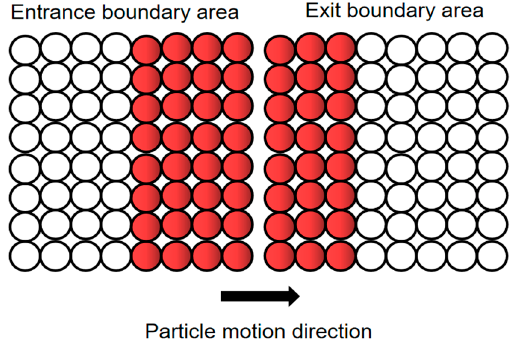
Figure 1. Flow boundary diagram.